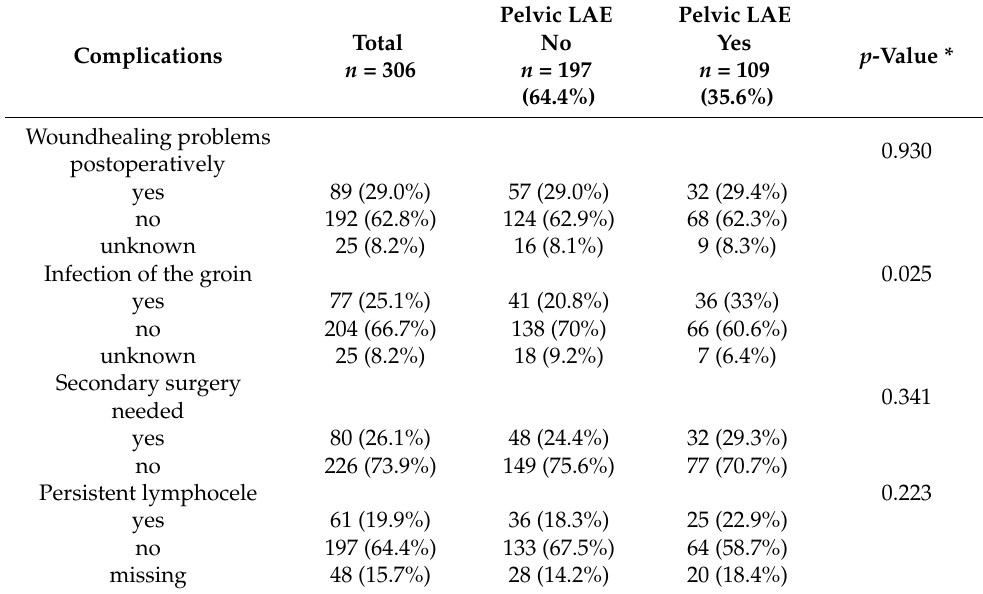
Table 4. Complications with reagrd to surgical